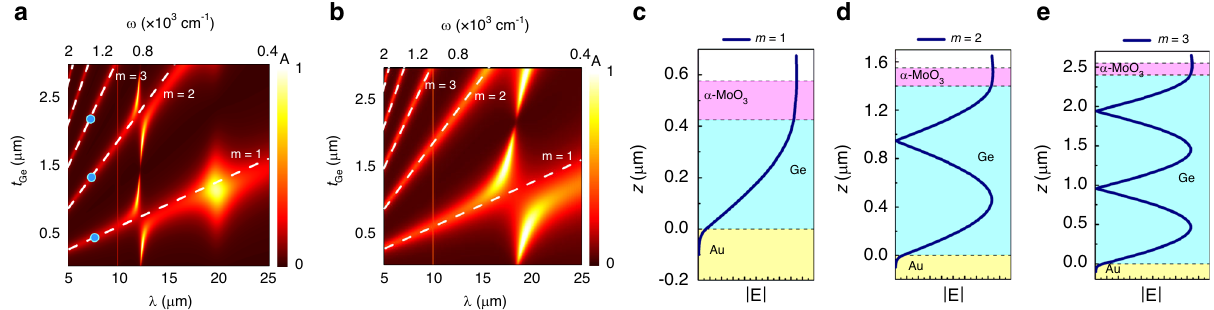
Fig. 2 Dispersion of α -MoO 3 FP cavity with t Ge . a Simulated dependence of total absorption on wavelength/frequency and Ge thickness ( t Ge ) where α - MoO 3 thickness is kept constant at t MO = 0.15 μ m for ( a ) x ( ϕ i = 0°) and ( b ) y ( ϕ i = 90°) phonons. Simulated electric fi eld magnitude | E | in the cross section of the studied multilayer system for t MO = 0.15 μ m and ( c ) t Ge = 0.42 μ m ( m = 1), ( d ) t Ge = 1.4 μ m ( m = 2) and ( e ) t Ge = 2.4 μ m ( m = 3). Note that the scales in panels c – e are not the same due to the t Ge difference. The dashed lines in panels a and b represent the FP mode orders. The dots on panel a mark the mode pro fi le simulations of panels c – e . function), while ω LO ,j and ω TO ,j represent LO and TO phonon frequencies that bracket each RS band along the corresponding direction j . The values used for these parameters are taken from the recently reported experimental data by Álvarez-Pérez et al. 40 and the results are provided in Fig. 1b, c. It is evident from this fi gure that there are three RS bands between 540 and 1010 cm − 1 (9.9 and 18.5 μ m), each of which is designated by vertical color- coded dashed lines in Fig. 1b, c. As a result, there are various hyperbolic regions in this spectral range. For frequencies above ω = 1007 cm − 1 (wavelengths below λ = 9.93 μ m), the real part of permittivity along all directions is positive and unequal. At lower frequencies where 963 cm − 1 < ω < 1007 cm − 1 , Re( ε z ) < 0 and Re ( ε x )Re( ε z ) > 0 and Re( ε y ) > 0, resulting in type 1 hyperbolicity in xz and yz planes, as shown in prior works 36,37,39,40 . At 547 cm − 1 < ω < 963 cm − 1 there are several bands of type 2 hyperbolicities, Re ( ε z ) > 0 and/or Re( ε x )Re( ε z ) < 0, Re( ε y )Re( ε z ) < 0. More impor- tantly, when 545 cm − 1 < ω < 821 cm − 1 we observe in-plane hyperbolicity that is essential for manipulating the polarization state of light impinging in the direction of optical axis ( z ).